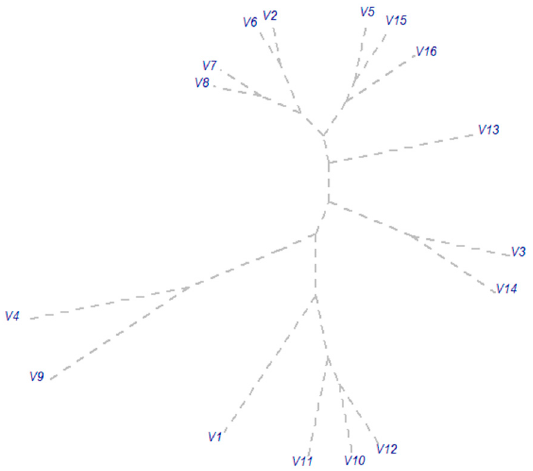
Figure 2. Cluster analysis of the inter-annual profile of the arbuscular mycorrhiza colonization winter wheat. Each point comprises the recorded values of frequency, intensity, arbuscularity, and colonization degree for that specific treatment in all three experimental years. Total N and P (kg ha − 1 ) corresponding to each treatment and fertilizer type: V1–N40P40 (N20P20); V2–N80P80 (N20P20); V3– N120P120 (N20P20); V4–N40P40 (N18P46 + ammonium nitrate (AN)); V5–N147P80 (N20P20 + AN);